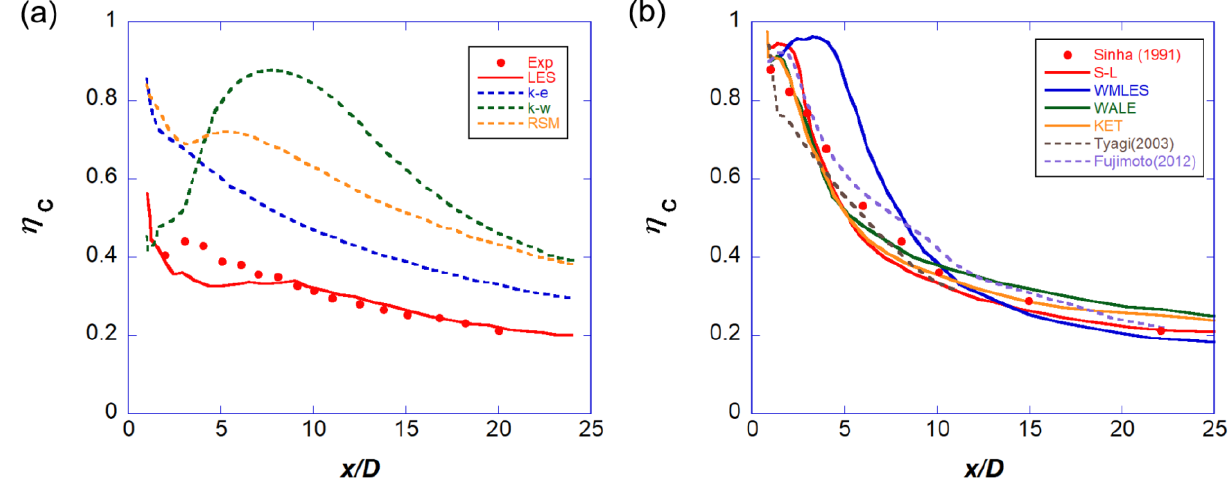
Figure 2. Centerline film-cooling effectiveness: ( a ) LES and RANS simulation data for M = 1.0 [6] and ( b ) LES data for M = 0.5 [5], compared to Sinha [104], Tyagi [18] and Fujimoto [105].